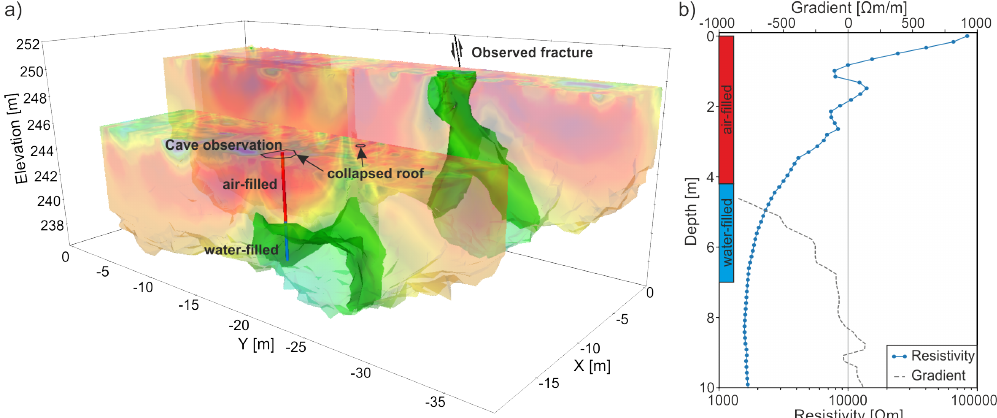
Figure 9. Resistivity model and ground truth. ( a ) Iso-surface ρ = 2.5 k Ω · m (shown fully opaque) representing the shape of the cave. For the lower floor, the depth correlates well with in-field measurements of the water table in the cave, and the shape and location with observations from the collapsed cave roof. On the upper floor, the low resistive feature aligns with a clay-filled fracture observed next to the survey area in the adjacent rock wall (see Figure 2b). ( b ) Resistivity-depth profile at the location of the collapsed cave roof, where cave depth and water table were measured (as indicated in red and blue bars). Shown is also the resistivity gradient for the depths > 4.5 m. At the